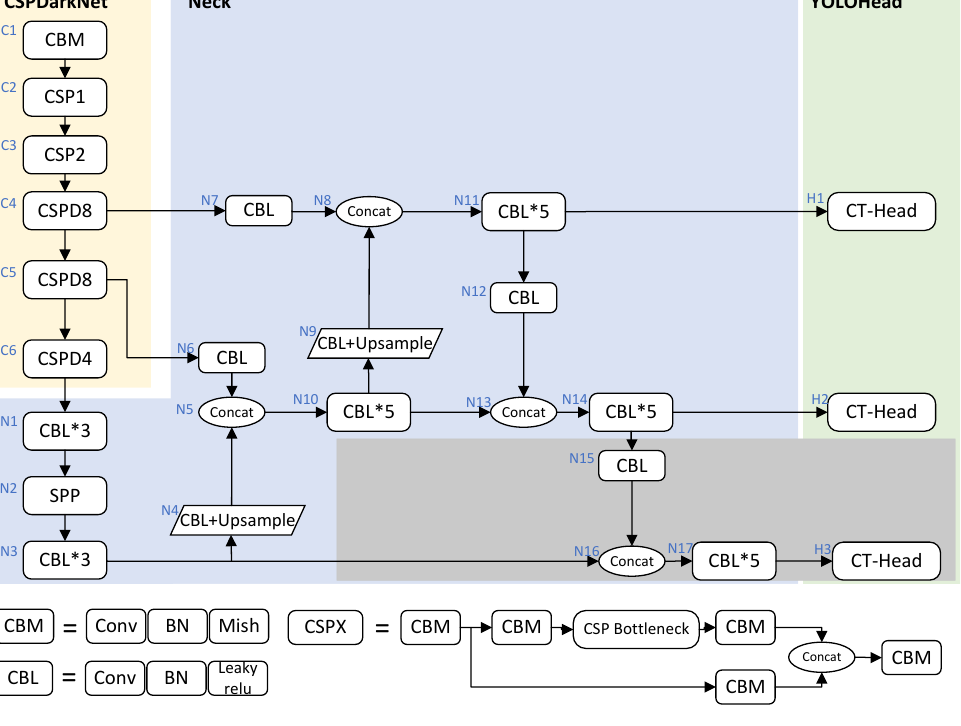
Figure 1. Structure of the YOLOv4